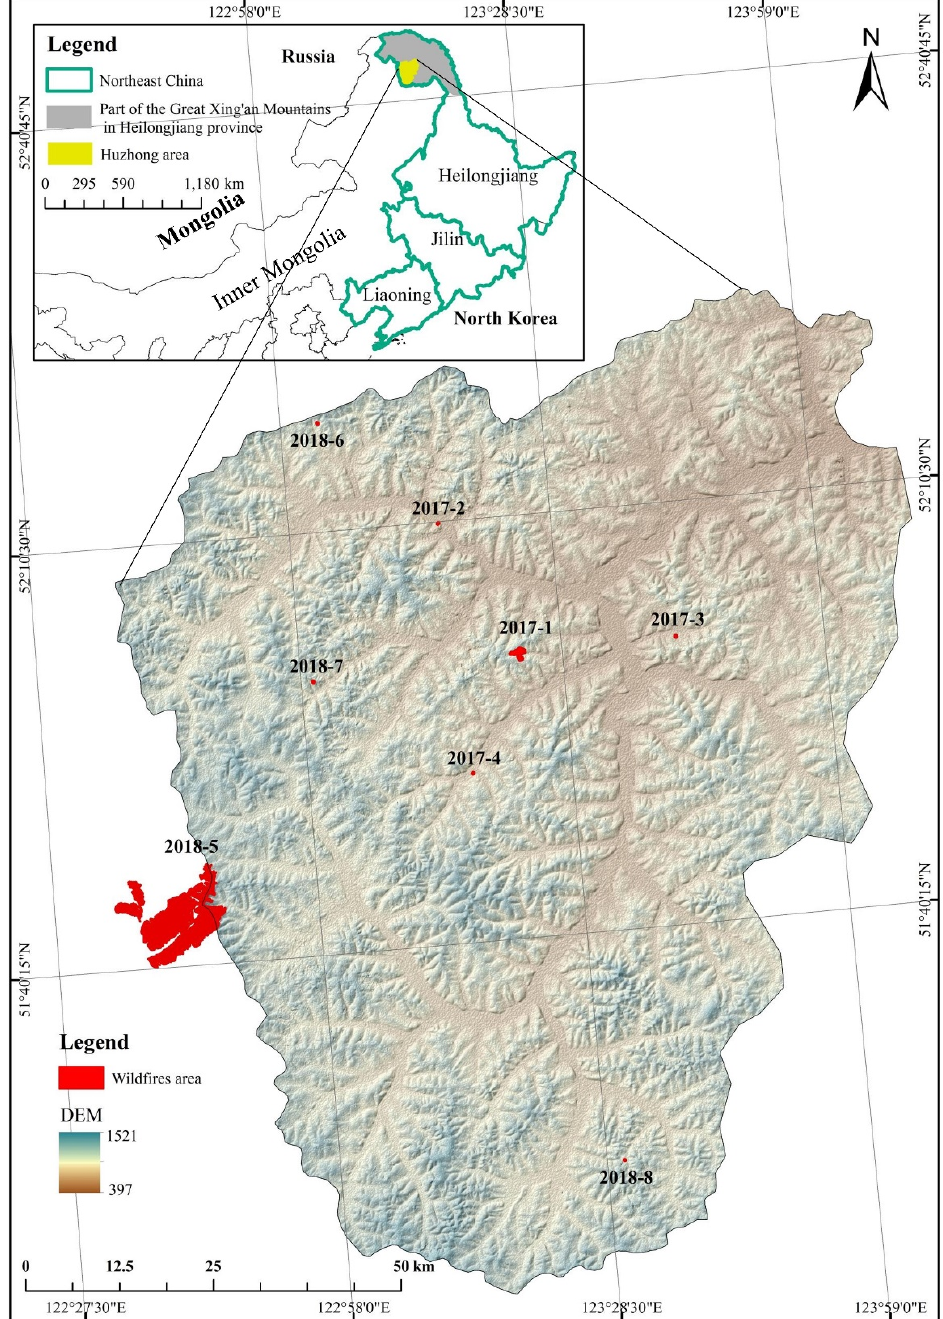
Figure 1. Location of the study area in the boreal forest of northeast China on the border of Russia.